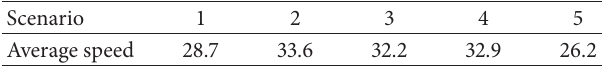
Table 6: Average car travel speeds (km/h) in five scenarios along Eastbound Shengli